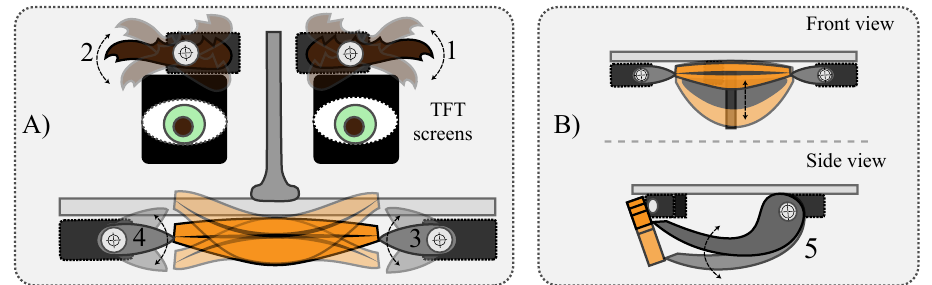
Figure 5. Mechanisms and actuators for the CASTOR robot’s face. ( A ) shows the elements (i.e., actuators, screens, and 3D-printed pieces) involved in the facial expressions. ( B ) illustrates in two views (i.e., front and side) the system for emulating the speech. The numbers represent the DOFs in this module.